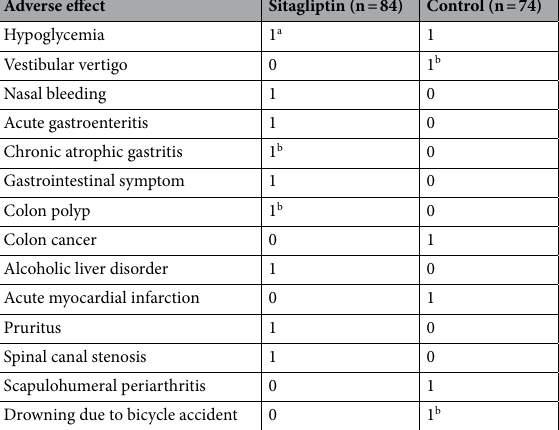
Table 4. Clinical adverse effects during treatment. Adverse events were analyzed in all patients according to the actual use of sitagliptin. Clinical adverse events were assessed in 84 patients treated with sitagliptin and 74 patients treated without, for whom information on adverse effects was available. a Two episodes were recorded. b Recorded on different occasions by a single